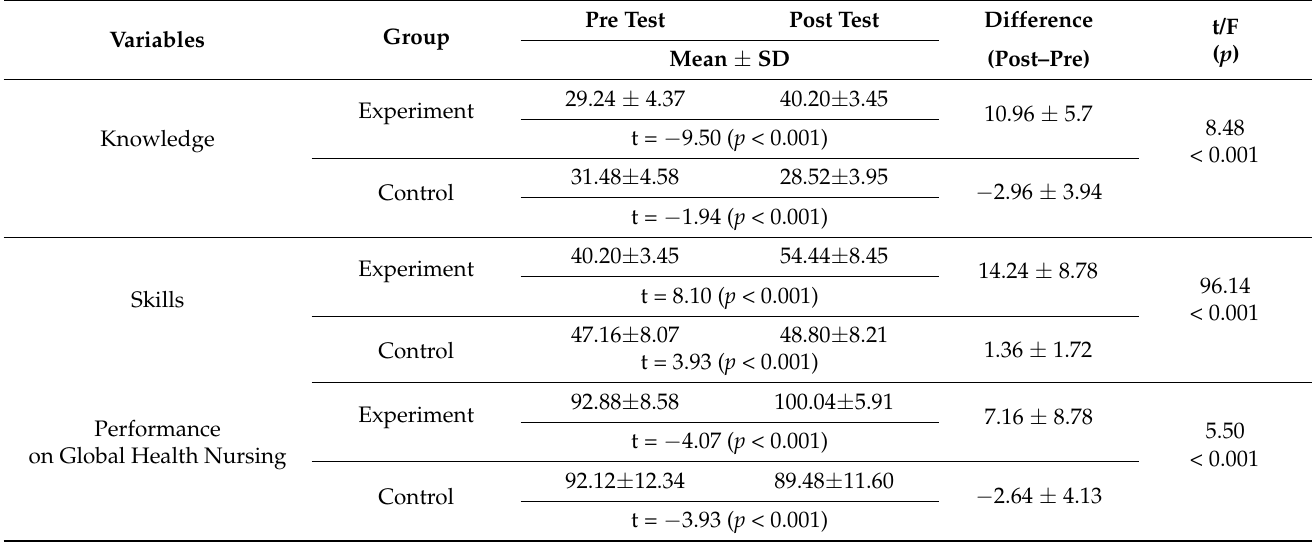
Table 5. Hypothetical Testing (N =